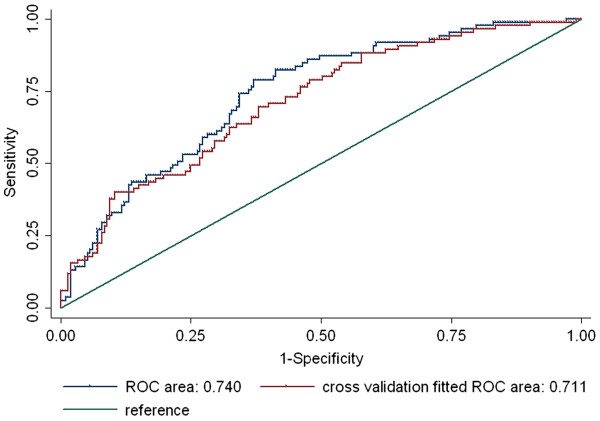
The ROC curve of the final model. The naïve model was fitted with Cox proportional hazard regression model using combined score (continuous) adjusted for BMI (< 25 and ≥25 kg/m2), TNM stage (I, II, and III), ER status (positive and negative) and radiation therapy (yes and no). The prediction error fitted ROC was estimated using 10-fold cross validation. Among the 303 patients, 298 subjects were used in ROC analysis since the subjects with missing values of any covariates were excluded.